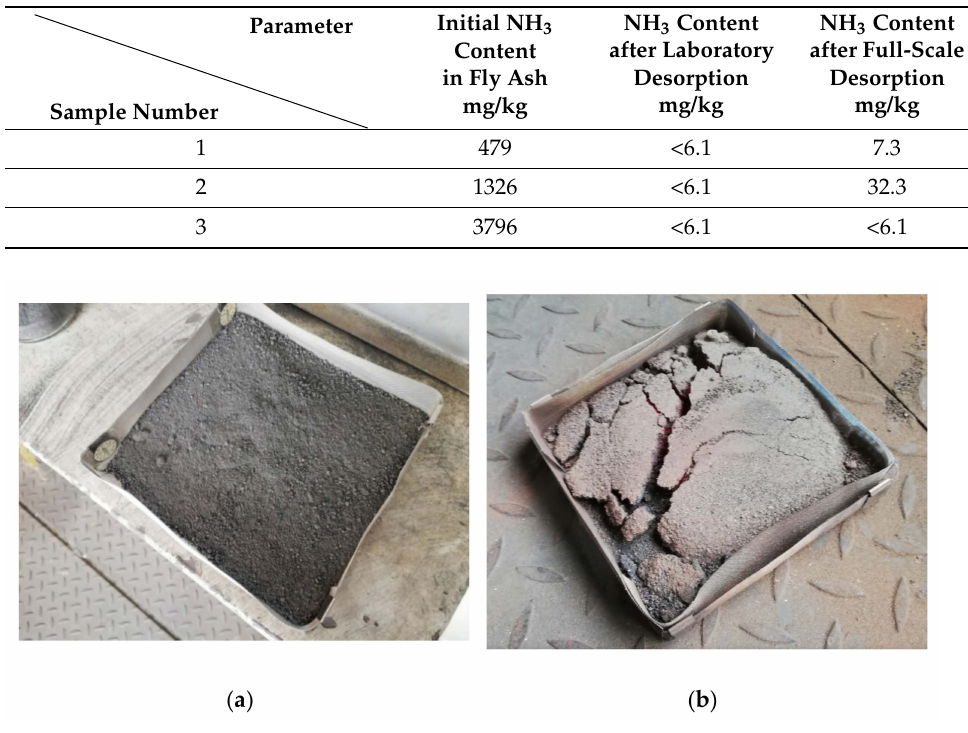
Figure 13. Fly ash sample before ( a ) and after decomposition on the grate ( b